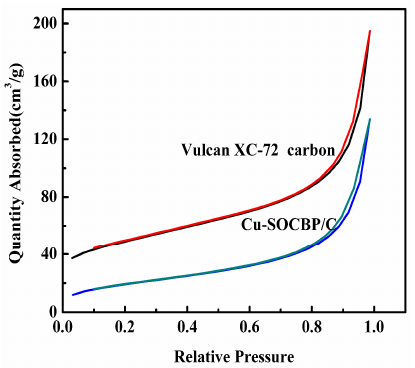
Figure 2. Nitrogen adsorption/desorption isotherms of Vulcan XC ‐ 72 and the Cu ‐ SOCBP/C composite.